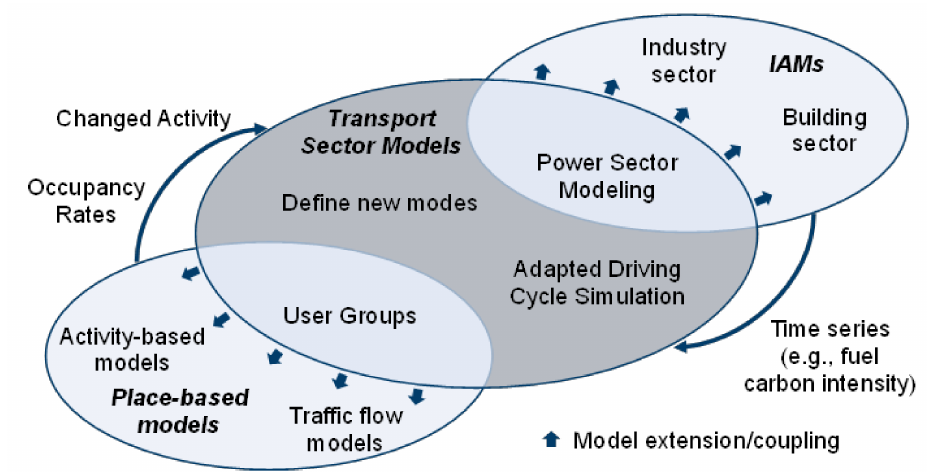
Figure 11. Overview of recommended transport sector model